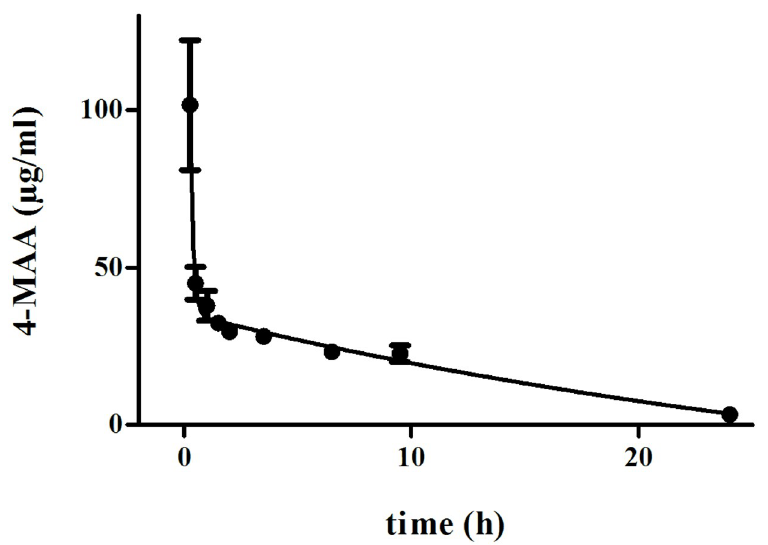
Fig 1. Plasma concentration over time of 4-MAA after intravenous administration of 40 mg/kg metamizole in calves subjected to ketamine/xylazine/isoflurane anesthesia. Values are the mean ± S.D. from n = 8 calves.